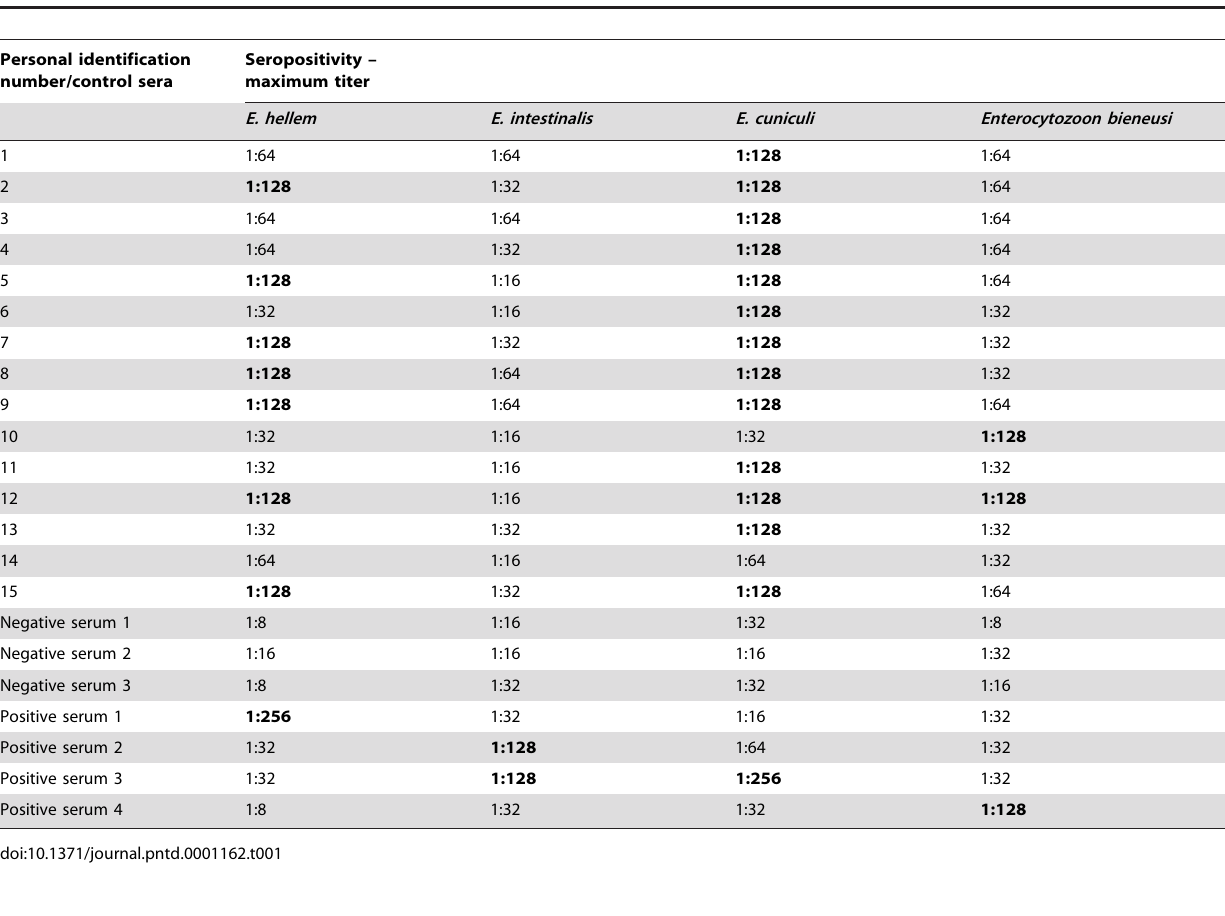
Table 1. Seropositivity to Enterocytozoon bieneusi and Encephalitozoon spp. at the beginning of the tested period.